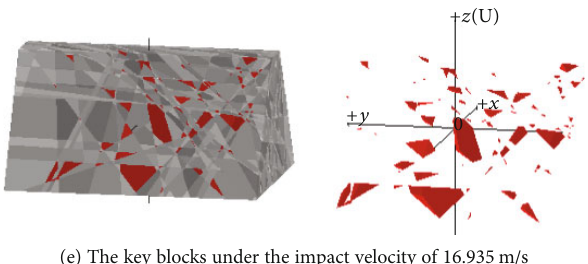
Figure 10: The number and distribution of key blocks under di ff erent impact